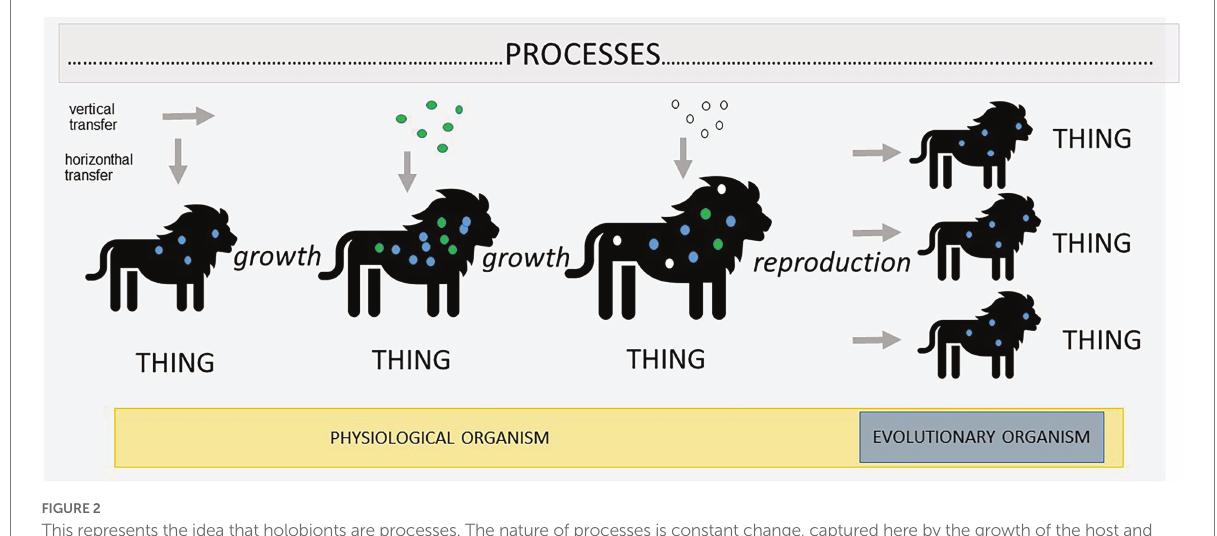
FIGURE 2 This represents the idea that holobionts are processes. The nature of processes is constant change, captured here by the growth of the host and change in the composition of its microbiota. Constant change does not imply that there is no stability at all. Processes may become sometimes so intertwined that they appear as cohesive wholes, called “things.” We believe that, at least in the case of holobionts, two such structures emerge: physiological individuality, in which cohesion is obtained through physiological interactions, and evolutionary individuality, in which cohesion is obtained through vertical transmission of